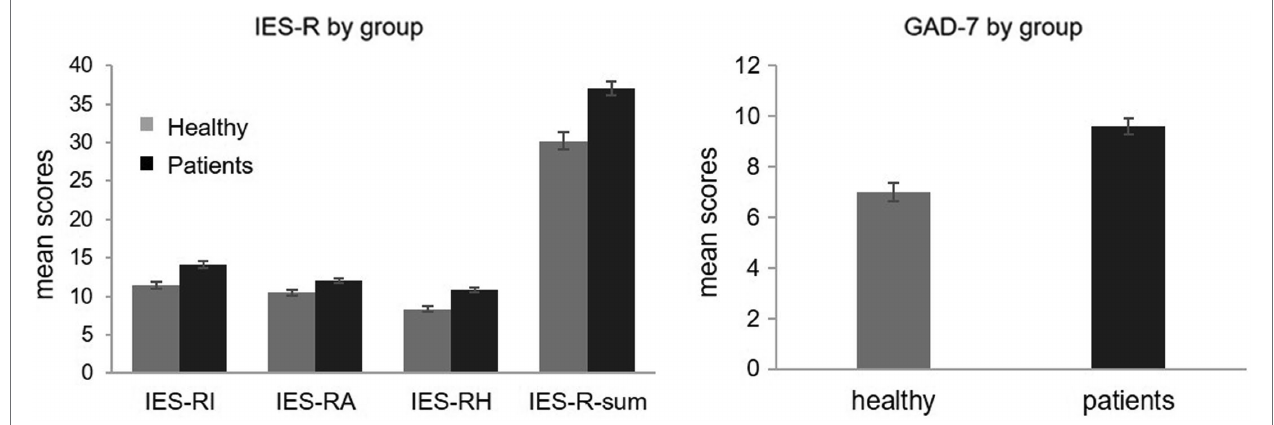
FIGURE 1 | Bar chart showing the mean scores for oncological patients (black) and healthy participants (grey) in IES-R (left) and GAD-7 (right).